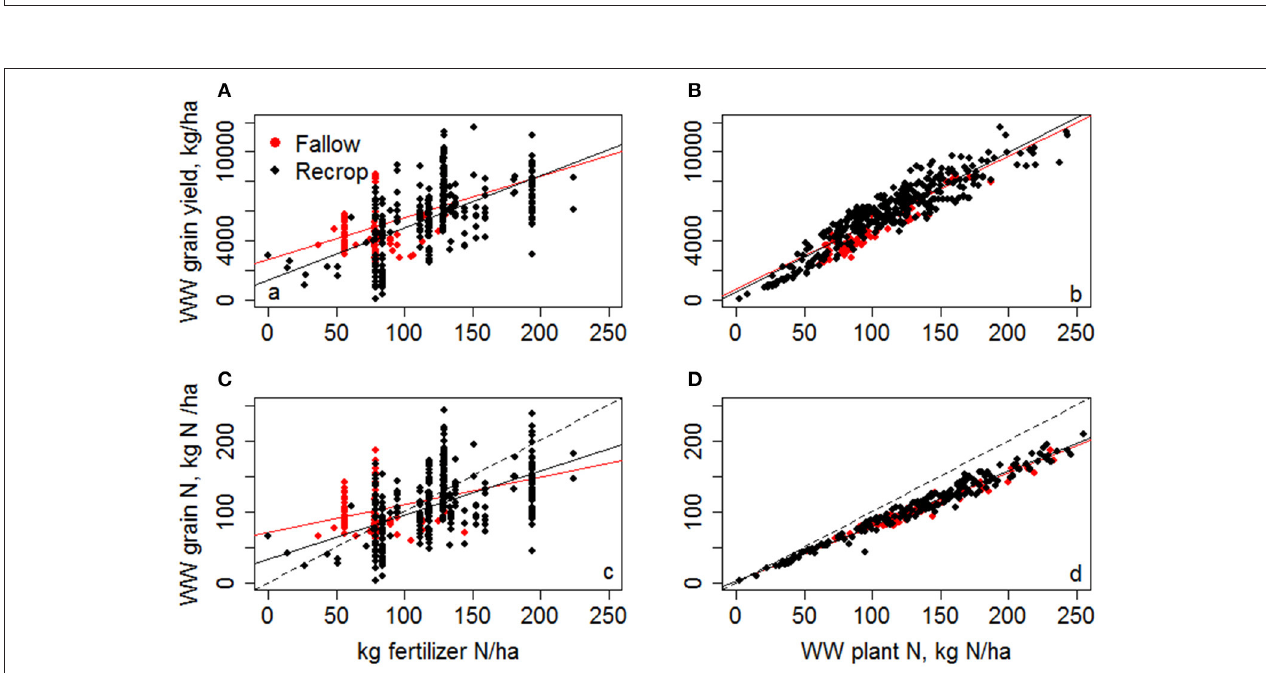
FIGURE 3 | Fertilizer use and N utilization efficiency of winter wheat in cropping systems research conducted in the inland PNW from 2011 to 2016, including (A) the response of winter wheat grain yields to fertilizer N, (B) the utilization efficiency of grain N to produce grain, (C) ratio of grain N export to fertilizer N additions, and (D) winter wheat N harvest index. Wheat was differentiated by cropping sequence, and was grown after fallow or crops (recrop). Broken line represents the 1:1 relationship.